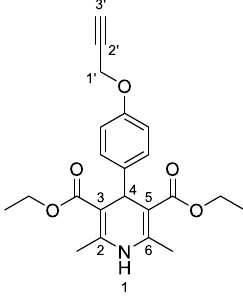
Figure 3. Chemical stucture of 3b . Figure 4). procedure